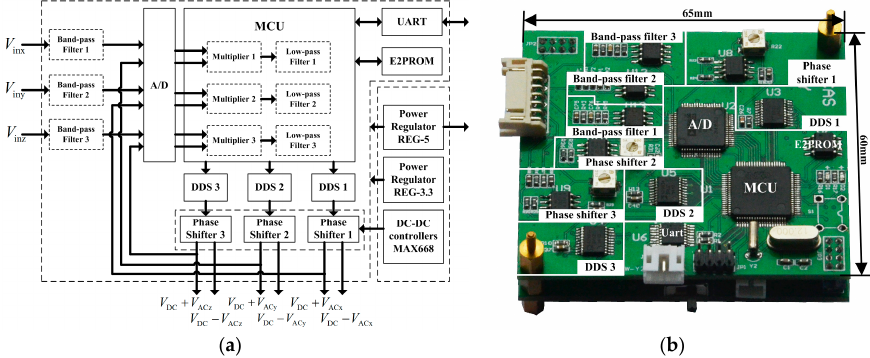
Figure 9. Back-end processing system. ( a ) Schematic view. V DC is the 20 V DC bias voltage of the driving signal. V inq is the output of the q -axis 1D EFSC after the front-end amplification system, V ACq is AC voltage of the driving signal of the q -axis 1D EFSC, q = x , y , z . The microcontroller unit (MCU) connects to three direct digital synthesizers (DDSs) to generate three AC voltages with programmed frequencies. The phase shifter is adopted to provide a 180° phase delay for the AC voltage. The band-pass filter aims to eliminate DC bias and high-frequency noise in the V inq so as to increase the signal-to-noise ratio. The back-end processing system interacts with the computer through universal asynchronous receiver/transmitter (UART); ( b ) picture of the back-end processing system. The size of back-end processing system is approximately 65 mm × 60 mm.